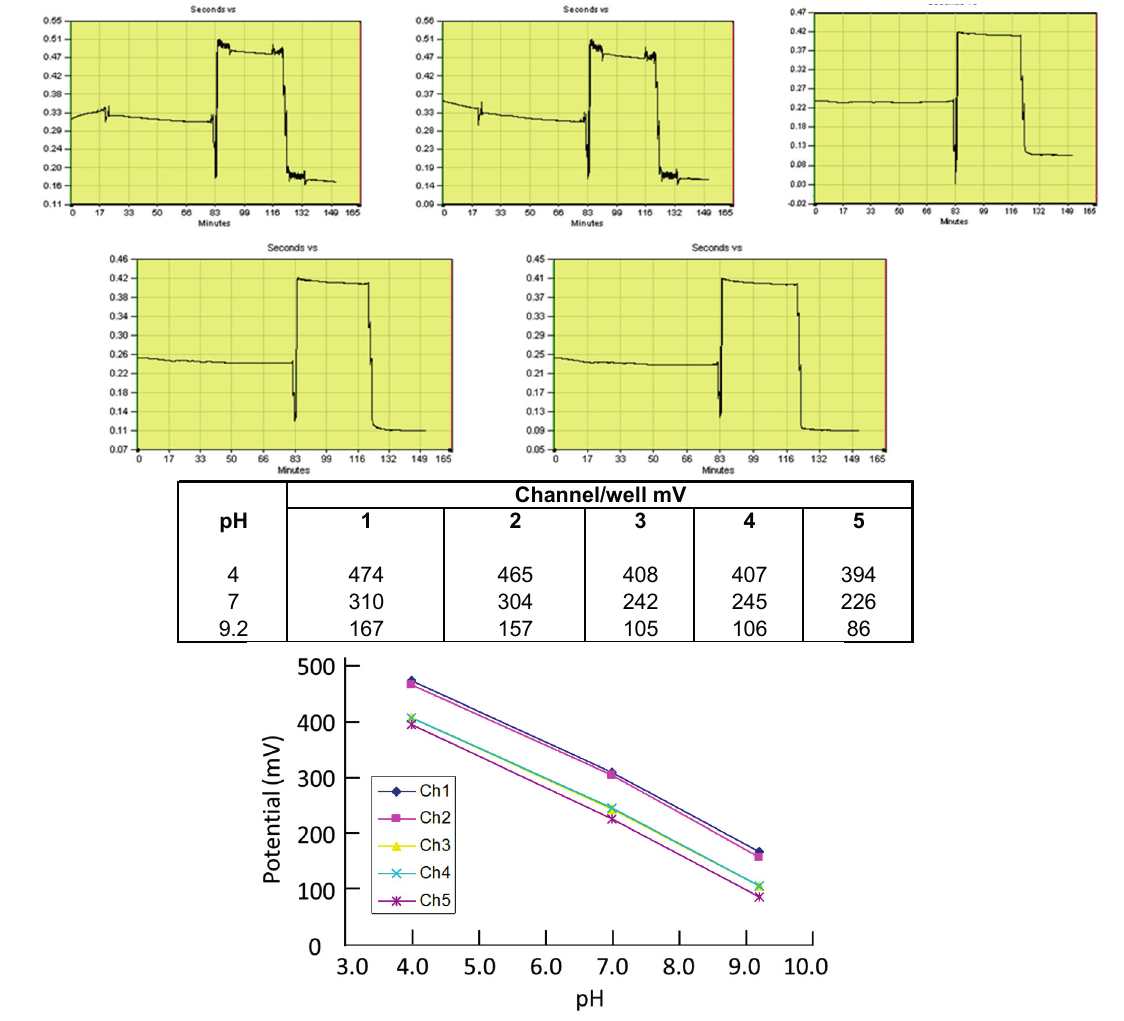
Figure 7. Screen-capture showing response of five pH sensors run in parallel in collagen-coated wells containing standard pH buffer solutions at pHs 4.0, 7.0 and 9.2. Table shows steady-state potential at each pH; graph shows slopes of potential vs. pH for each